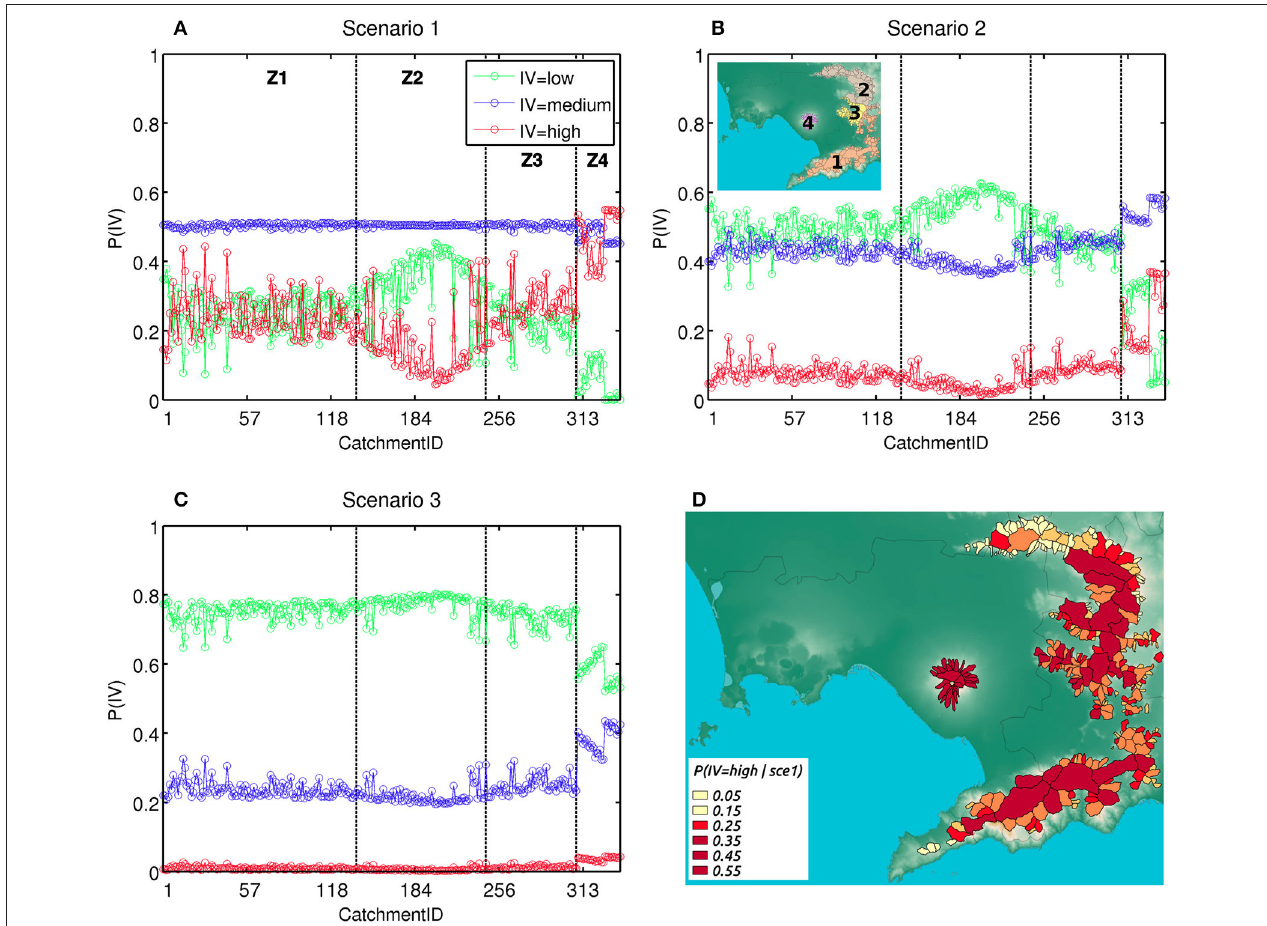
FIGURE 8 | Probability values for the initiation volume (IV) node across all the catchments defined at Somma-Vesuvius (Italy) and surroundings, according to three different scenarios: (A) high remobilization efficiency taking place after a large eruption; (B) medium remobilization efficiency taking place after a medium eruption; and (C) low remobilization efficiency taking place after an eruption of any size. Z1, Z2, Z3, and Z4 are large grouping of catchments (or zones) and their locations are shown in the inset map of (B) . Panel (D) displays the probability of large-volume lahars to occur at each catchment along the hazard domain in the event of scenario 1 [i.e., P(IV = high | scenario 1), red line in A ]. See text for more